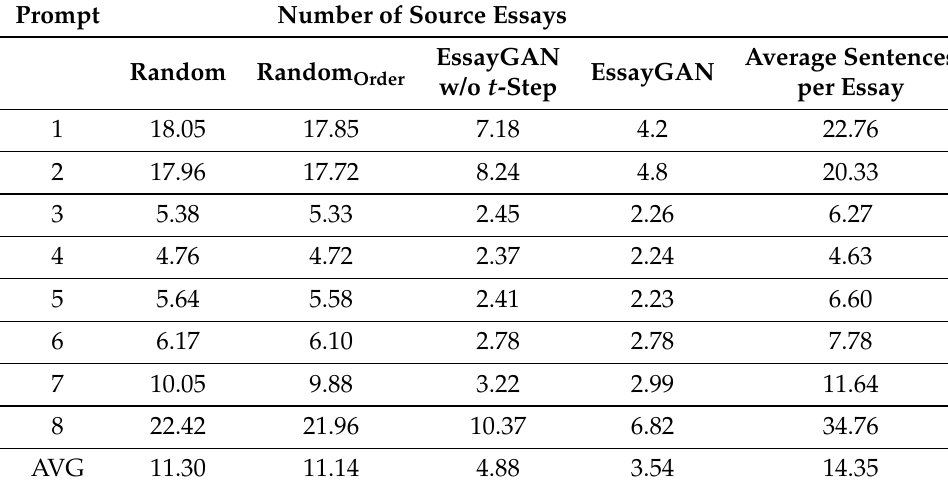
Table 3. Comparison of the number of source essays according to the augmentation techniques used.